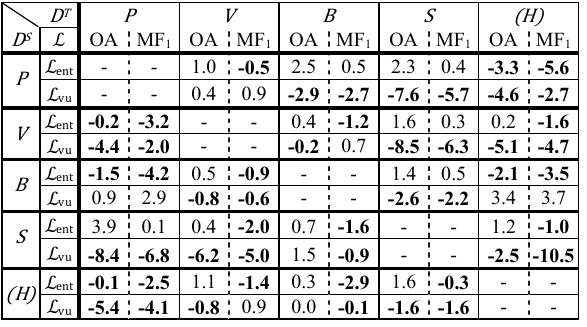
Table 5: Improvements in [%], achieved by adapting M S,Ω(cid:3397) to D T using alternative loss